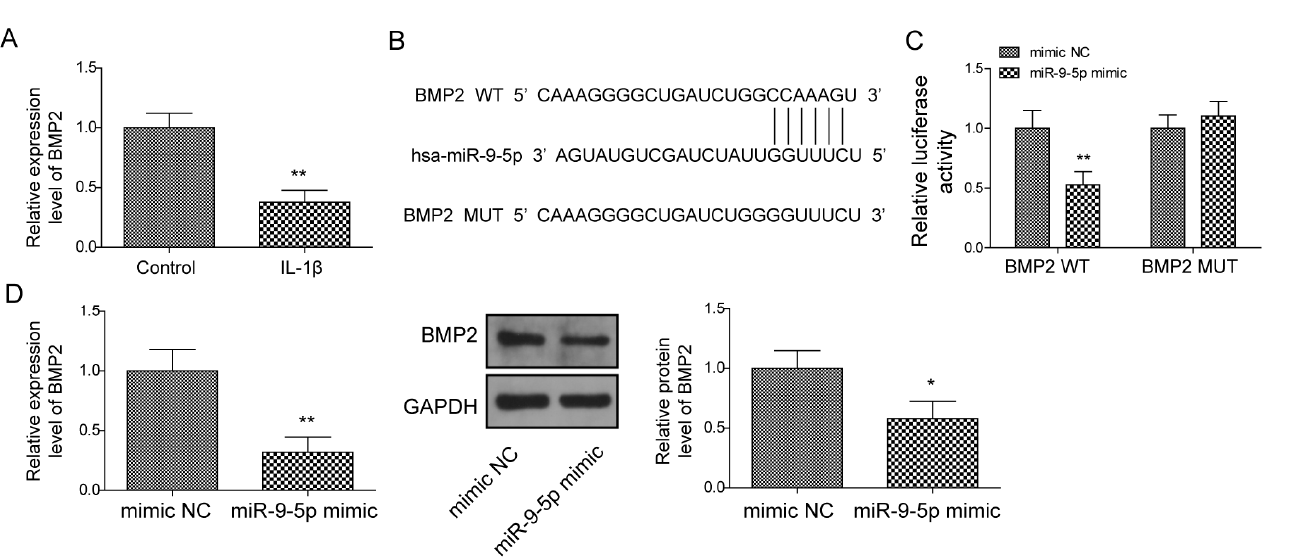
cells by flow cytometry. ( D , E ) Expressions of ECM proteins by Western blot ( E ) and immunofluores- cence ( E ). Data were estimated as mean ± SD. * p < 0.05, ** p < 0.01, *** p < 0.001.